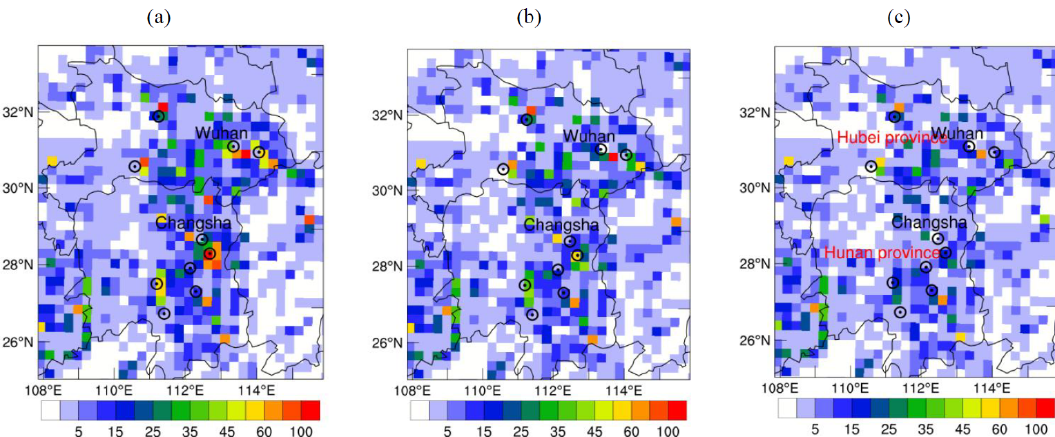
Figure 8. Emissions in central China for (a) MEIC_2016, (b) 2019, and (c) 2020. Black circles with dots are the locations of large cities. The red characters in (c) are the name of provinces, and the black characters are the name of cities. Wuhan and Changsha are the capitals of Hubei and Hunan provinces, respectively. Unit: molkm − 2 h − 1